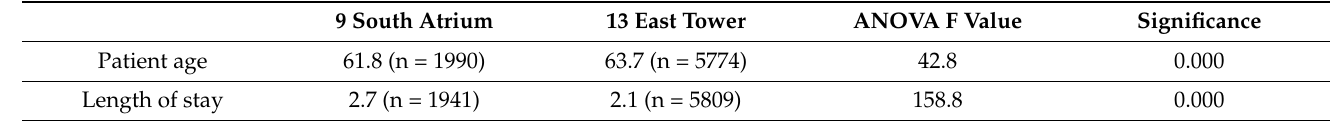
Table 4. Comparison of patient age and length of stay between 9 South and 13 East. 9 South